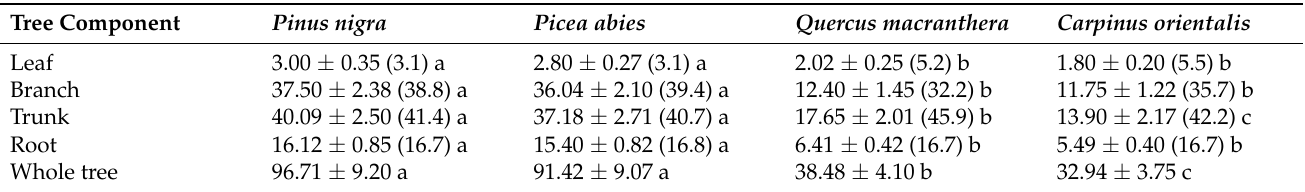
Table 5. Biomass (mean ± SD, kg tree − 1 ) of tree components. Values in brackets are the percentage of the tree component biomass to the whole tree